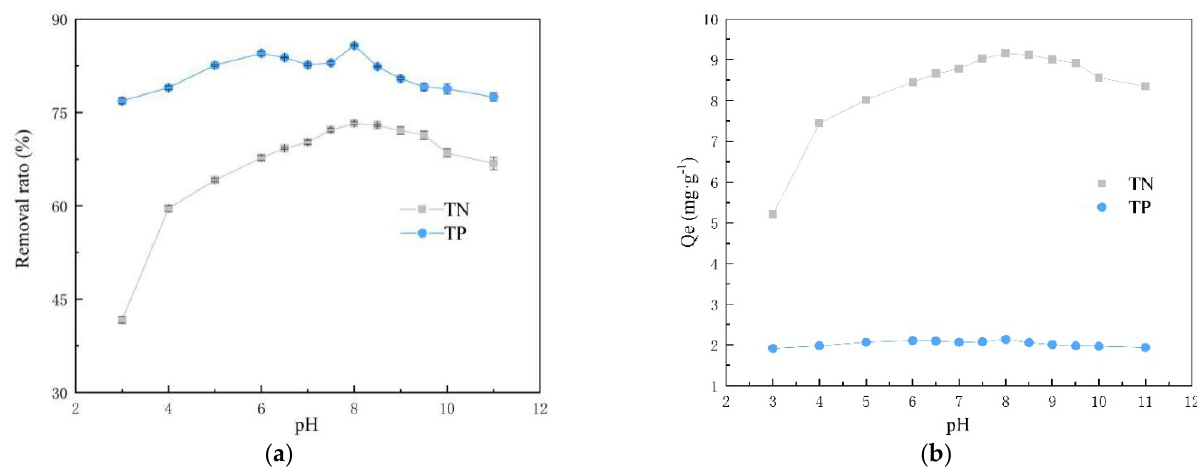
Figure 7. Effect of solution pH value on simultaneous ammonium and phosphorus removal. ( a ) Change graph of removal rate with increasing pH value, ( b ) change graph of unit adsorption capacity with increasing pH value (C P0 = 10 mg/L; C N0 = 50 mg/L; pH = 7.0; T = 25 °C; adsorbent dosage = 4 g/L; t = 90 min) .